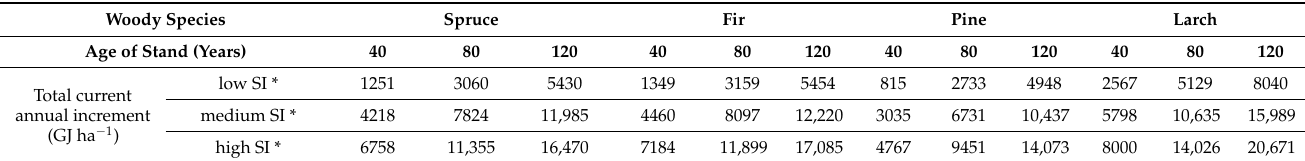
Table 5. The development of the energy reserves in the above-ground biomass of stands with low, medium and high site